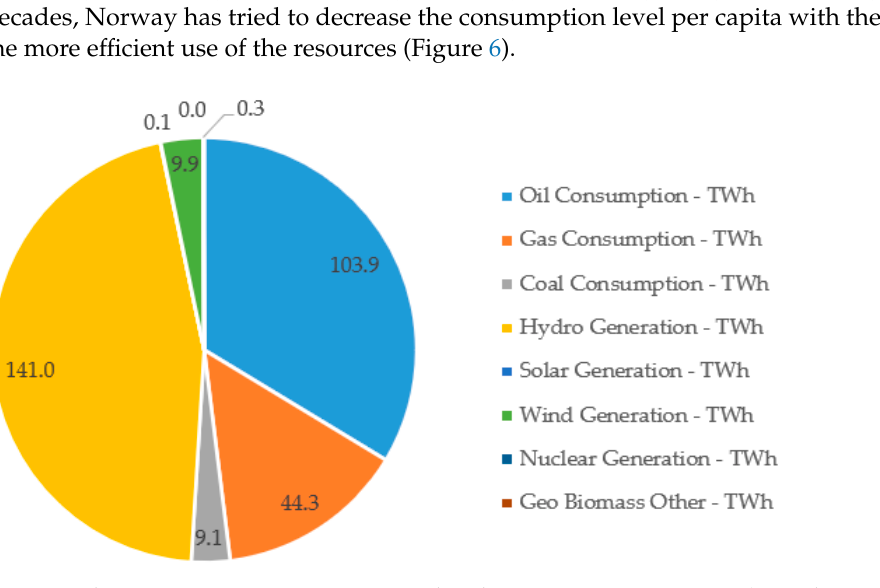
Figure 5. The energy consumption resource distribution in Norway in 2020 (according to the data source [14]).